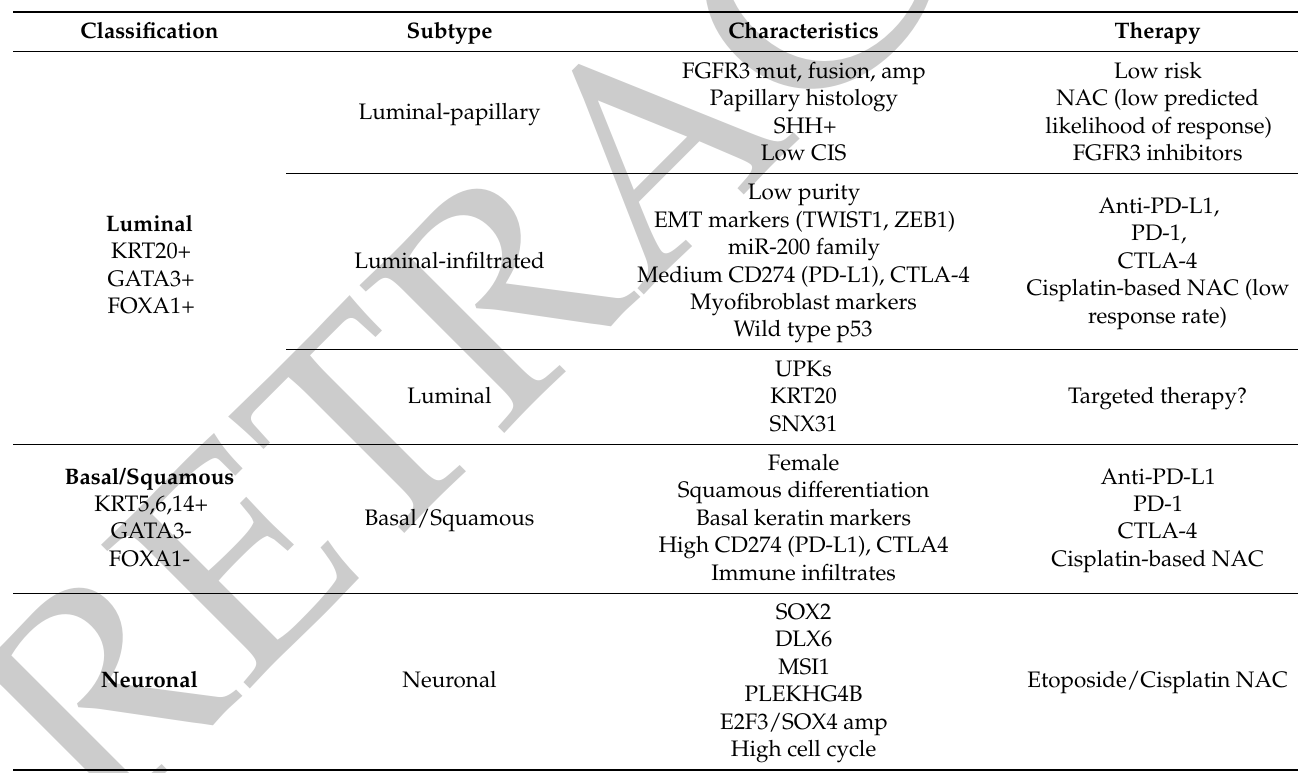
Table 1. Proposed schematic illustration of the expression-based, subtype-stratified therapeutic approach as a framework for prospective hypothesis testing in clinical trials. Adapted from A. Gordon Robertson, Comprehensive Molecular Characterization of Muscle-Invasive Bladder Cancer, 2017, Cell 171